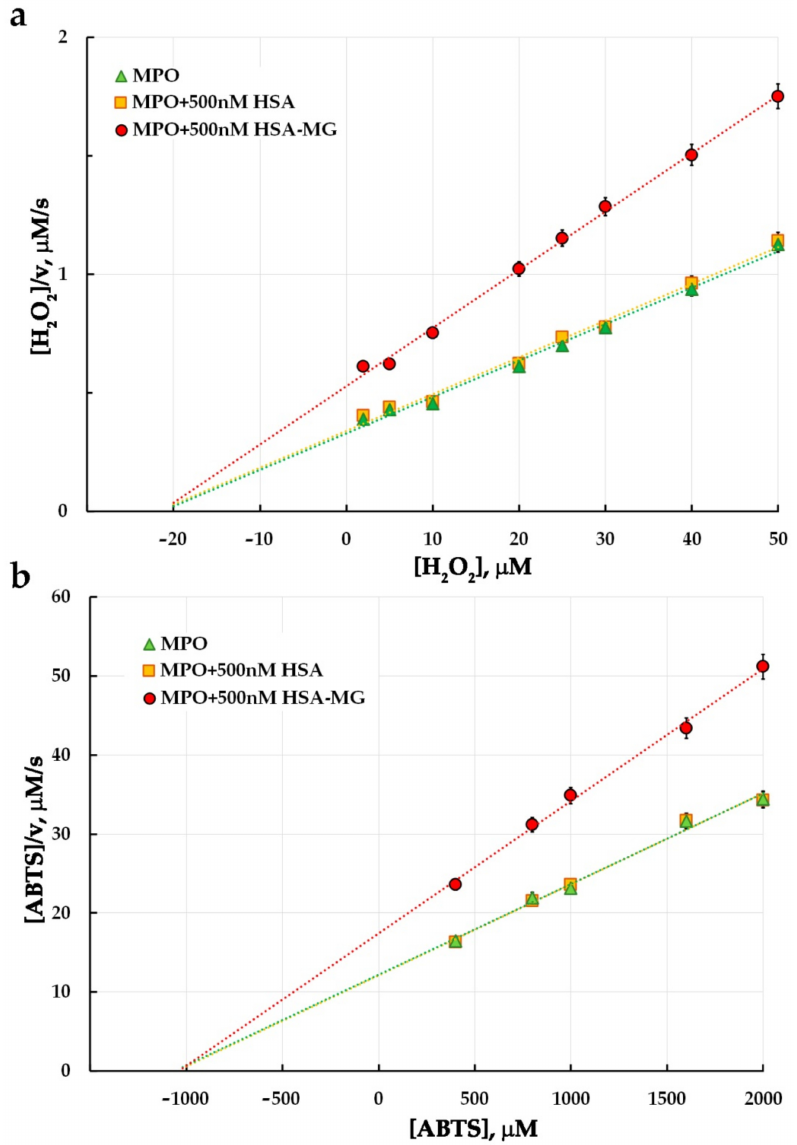
Figure 5. Hanes–Woolf plots illustrating the effect of HSA-MG on kinetics of MPO-catalyzed ABTS oxidation ( n = 3). ( a ) The mixture contained 1 mM ABTS, 5 nM MPO, 2–50 µ M H 2 O 2 in 50 mM sodium acetate buffer, pH 5.5; HSA or HSA-MG were added to achieve concentration of 0.5 µ M. ( b ) The mixture contained 50 µ M H 2 O 2 , 5 nM MPO, 0.4–2.0 mM ABTS in 50 mM sodium acetate buffer, pH 5.5; HSA or HSA-MG were added to achieve concentration of 0.5 µ